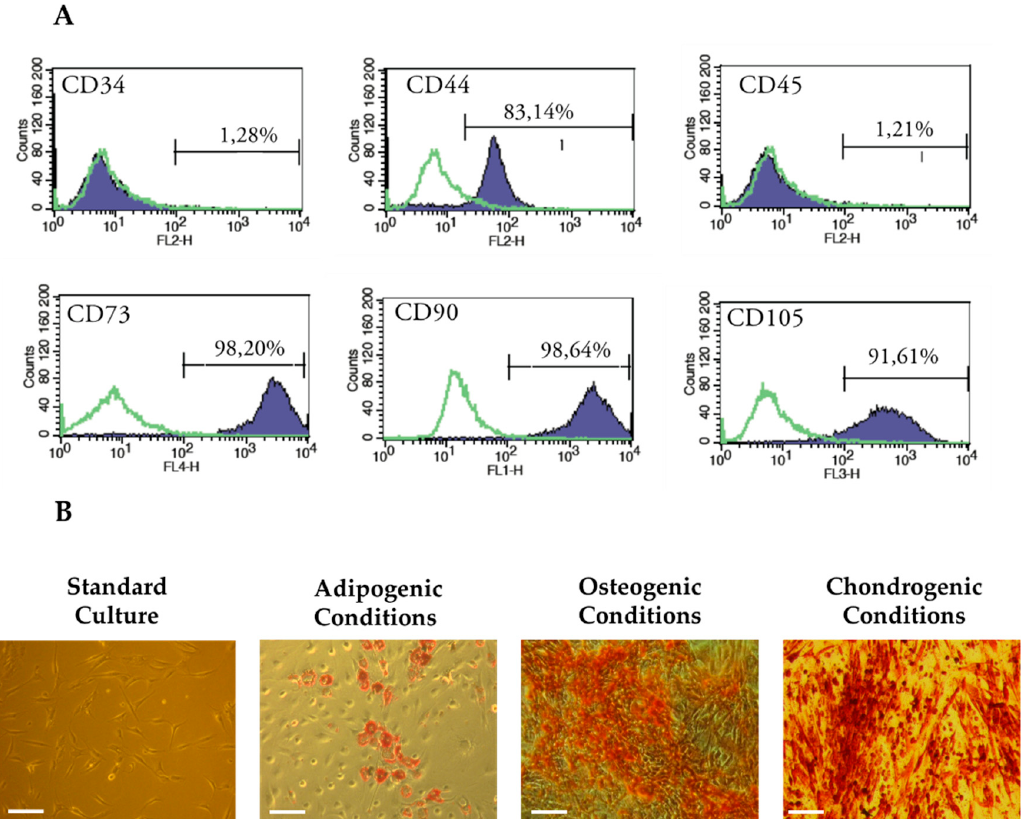
Figure 3. The results of immunophenotyping and multipotency assay of population of human adipose-derived stem cells used in the experiment. Flow cytometry revealing the positive expression of CD44, CD73, CD90 and CD105 mesenchymal markers and negative expression of CD34 and CD45 ( A ); The morphology of hASCs in standard, adipogenic, osteogenic and chondrogenic culture was presented ( B ), scale bar = 100 µm. The lipid-rich vacuoles in adipogenic cultures were stained with Oil Red O, the calcium deposits in osteogenic cultures were detected using Alizarin Red, while accumulation of proteoglycans in chondrogenic cultures visualized using Safranin-O.